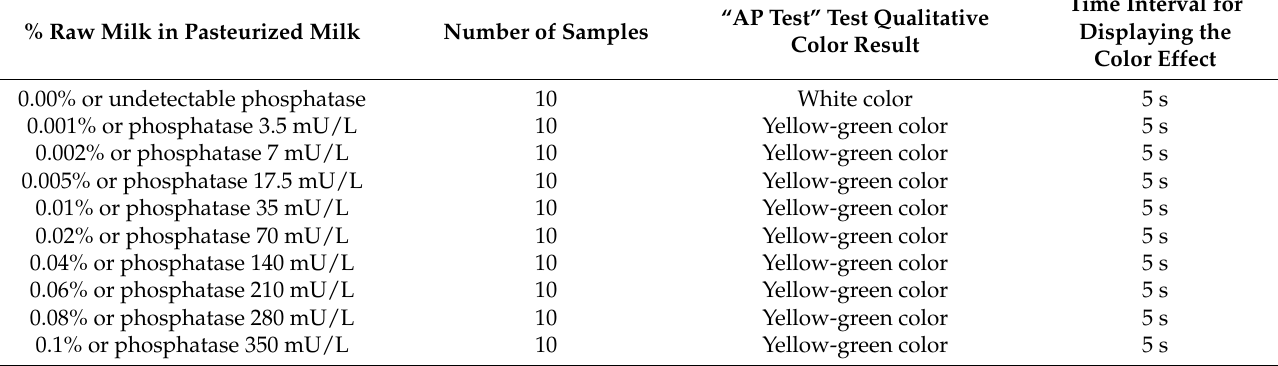
Table 1. Detection of LoD for “AP test” in pasteurized milk. Positive control = yellow-green color (presence of phosphatase in the sample). Negative control = white color (absence of phosphatase in the sample).